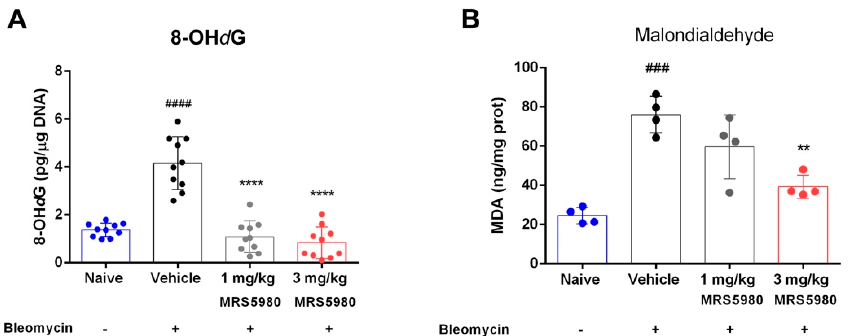
Figure 7. Evaluation of oxidative stress markers. Levels of 8-OH d G ( A ), a marker of DNA damage induced by production of free radicals. n = 10 animals per group. Levels of MDA ( B ), a marker of end-products of cell membrane lipid peroxidation by ROS, are evaluated in lung tissues. n = 4 animals per group. Data are mean ± S.E.M. #### p < 0.0001 and ### p < 0.001 vs. naïve; **** p < 0.0001 and * p < 0.05 vs. vehicle.